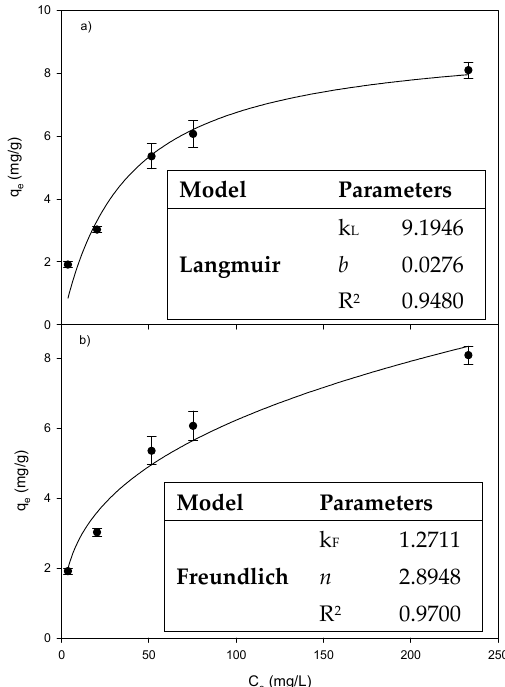
Figure 5. Isotherms models: ( a ) Langmuir; and ( b ) Freundlich. Operational conditions: Cr(VI) concentration 50–500 mg / L, PP dosage 1.50, pH 2 and temperature 30.05 ◦ C during 24 h. Table 4. Adsorption test conditions and uptake capacities of various adsorbents for Cr(VI) removal.